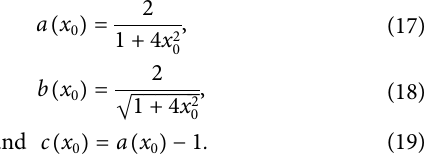
with respect to x and t , which are presented in the upper and lower